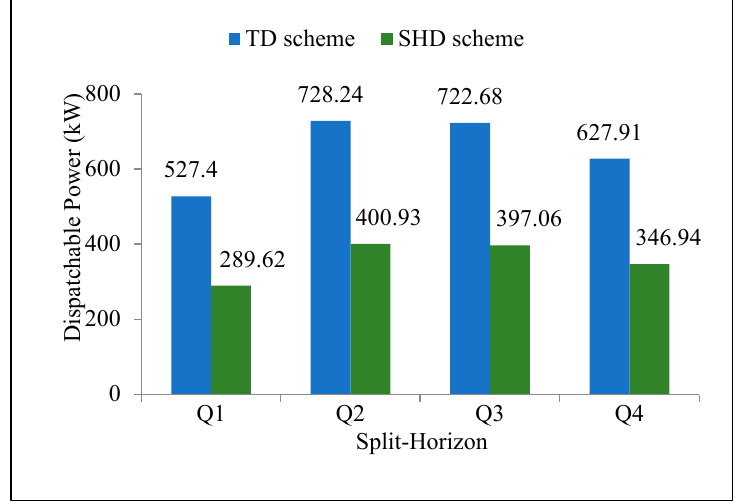
Figure 8. Average power reserve in each quarter.